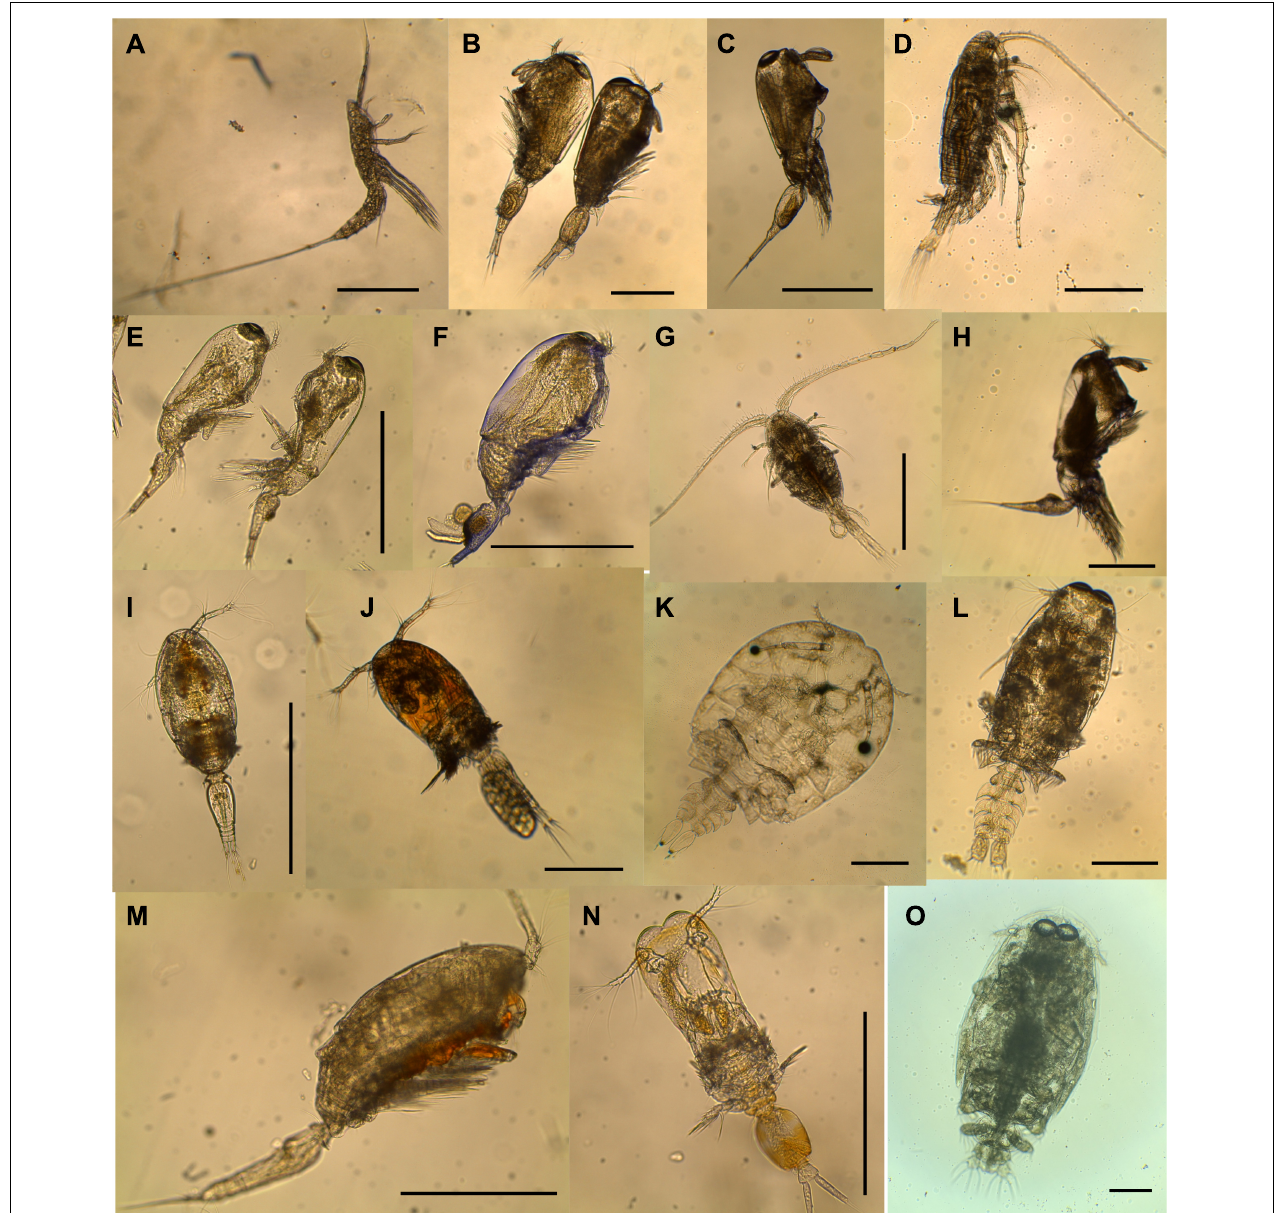
FIGURE 3 | Examples of common species of copepods collected during October to November 2015 in the SPSG. (A) Aegisthus mucronatus , (B) Agetus limbatus , (C) Agetus typicus , (D) Centropages brachiatus , (E) Farranula curta , (F) Farranula gibbula , (G) Lucicutia gaussae , (H) Monocorycaeus robustus , (I) Oncaea media , (J) Oncaea mediterranea , (K) Sapphirina intestinata , (L) Sapphirina metallina , (M) Triconia conifera , (N) Vettoria parva , (O) Order Siphonostomatoidea (Familiy Pandaridae). The black scale is 500 µ m.